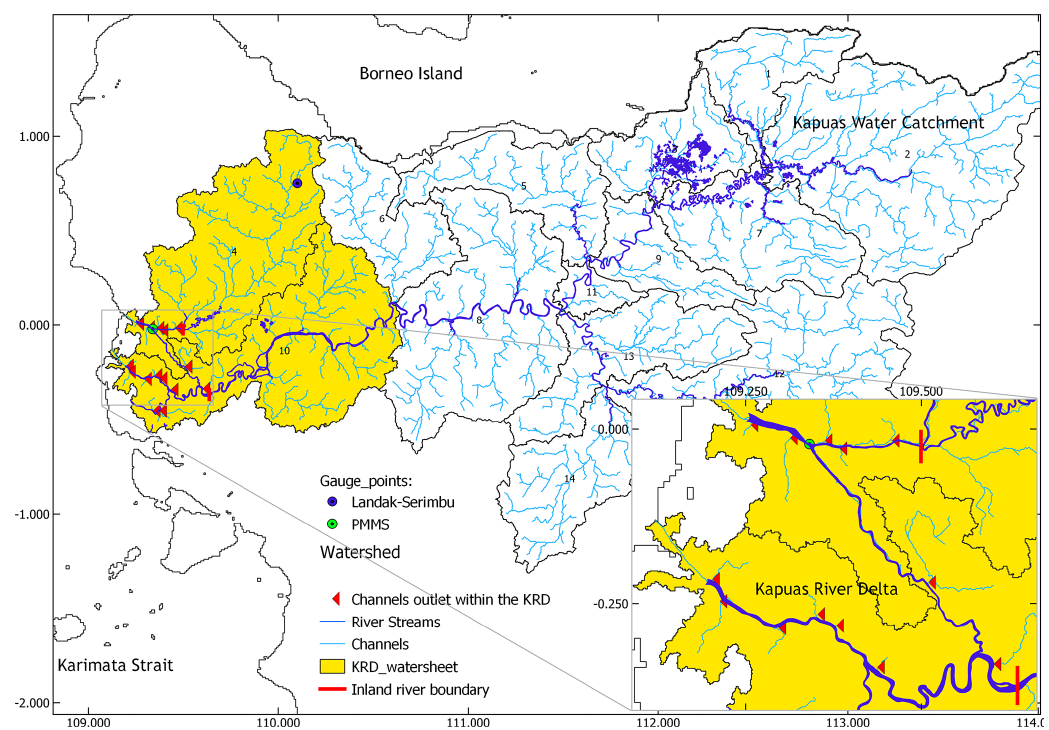
Figure 4. The Kapuas River watershed and its sub-basins. Since the discharges of the Kapuas River are retrieved at the middle stream, only two sub-basins are considered for the SWAT + model (yellow area). The runoffs (channel outlets of the SWAT + model that enter the river stream within the KRD) are set as inlets for the hydrodynamic model domain.